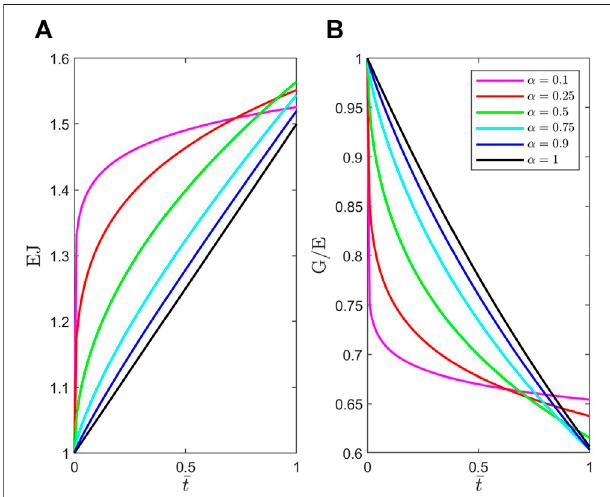
FIGURE2| Plotsofdimensionlessmaterialfunctions (A) EJ and (B) G / E given by Eq. 7 versus the dimensionless time (cid:2) t for various constant values of α ∈ ( 0 , 1 )